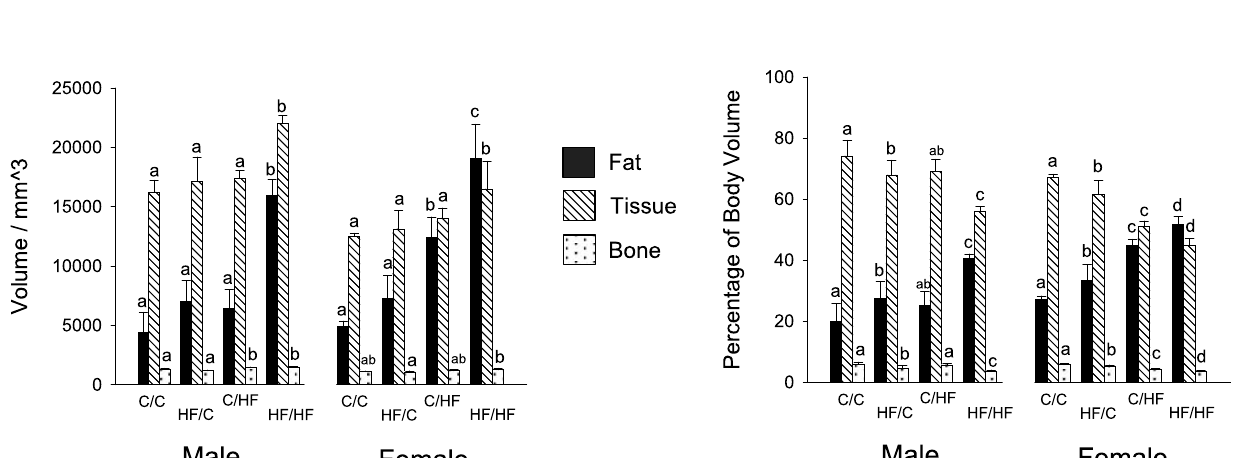
Fig 1. Offspring Mass and body Composition at Thirty Weeks of Age. Graphs show (A). Mass. (B). Fat, Tissue and Bone Volume. (C). Percentage of Body Fat, Tissue and Bone. Within each sex and for each tissue type, bars with different letters are significantly different (p < 0.05). For all groups, n = 5 – 7 per group. Graphs show mean plus 95% confidence